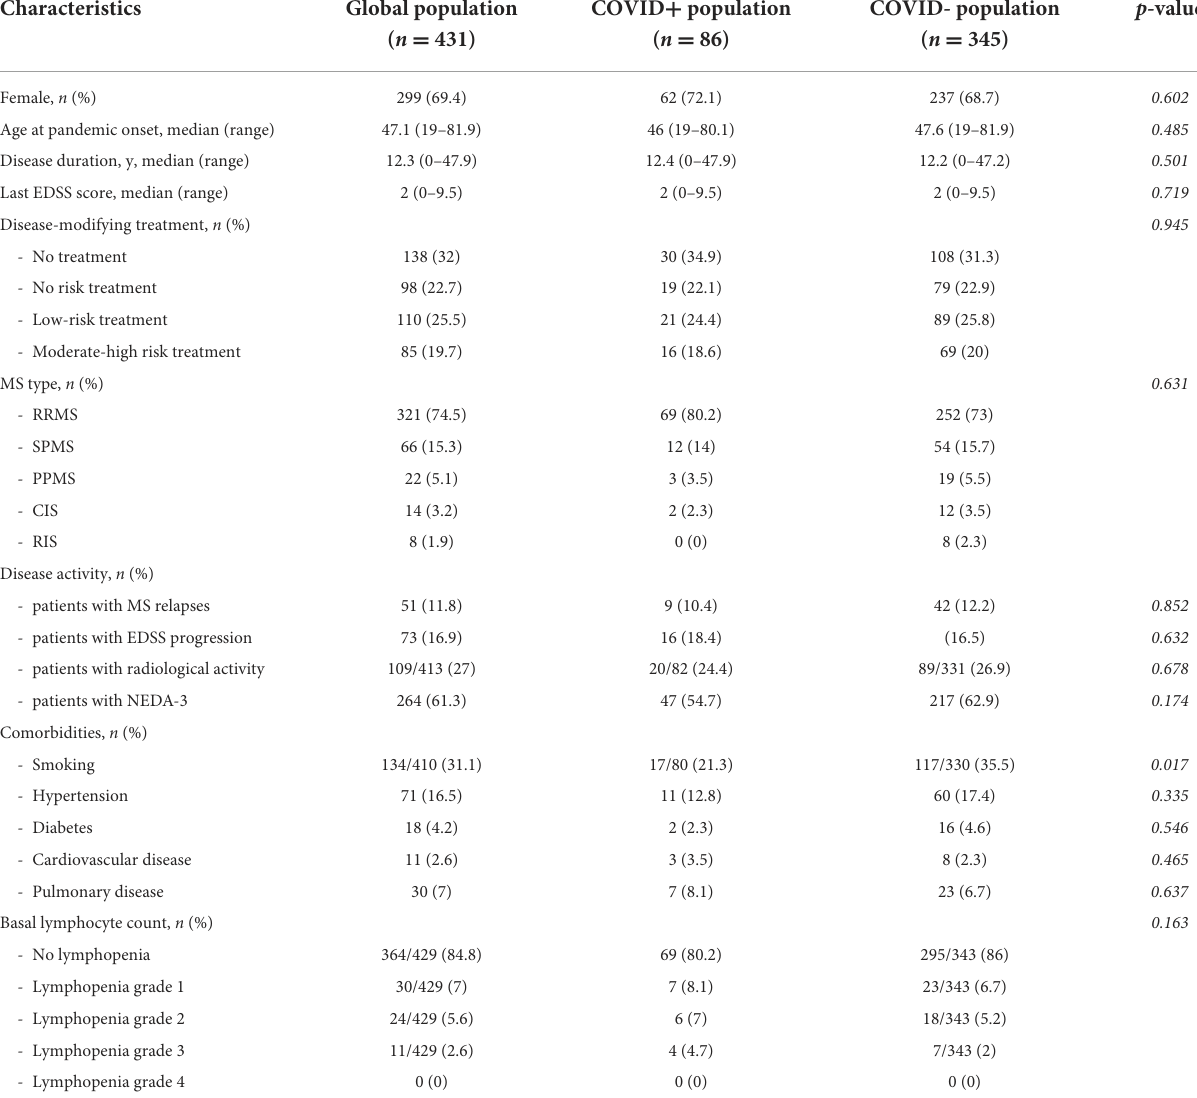
TABLE 1 Demographic, clinical characteristics, comorbidities, and basal lymphocyte count of pwMS-related disorders followed in University Getafe Hospital, as of 28 September 2021. Characteristics